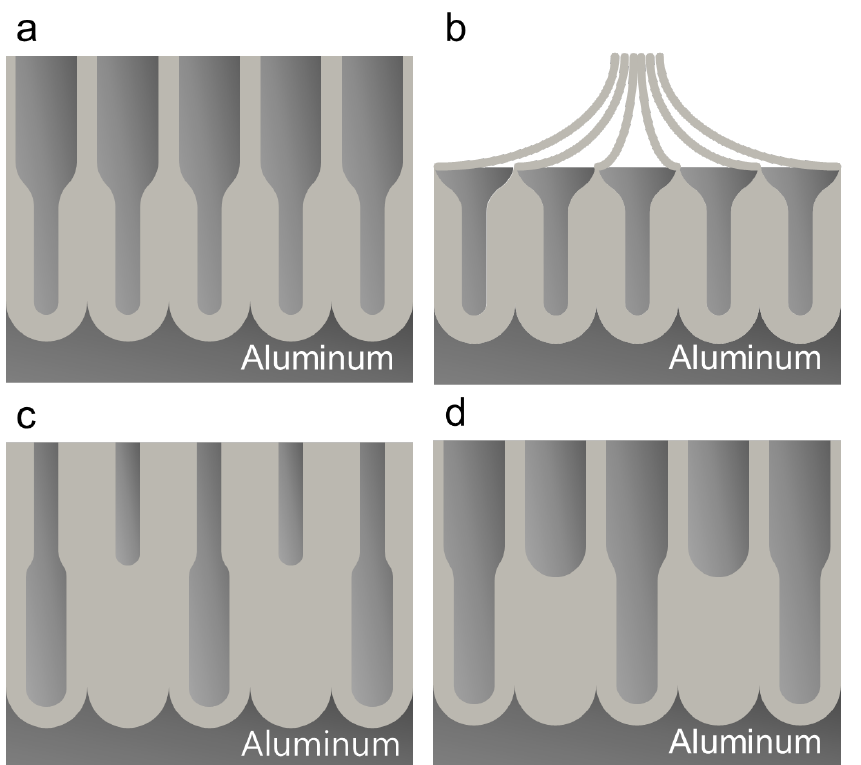
Figure 7. Schematics of the various types of the nanopore structures achieved by the stepwise anodizing processes with the modulation of the intermediate pore widening step. ( a ) Funnel-shaped nanopores. ( b ) Pillar-on-pore hybrid structures. ( c ) Bottle-shaped nanopores with Y-shaped merging of pore walls. ( d ) Funnel-shaped nanopores with M-shaped margining of pore walls.